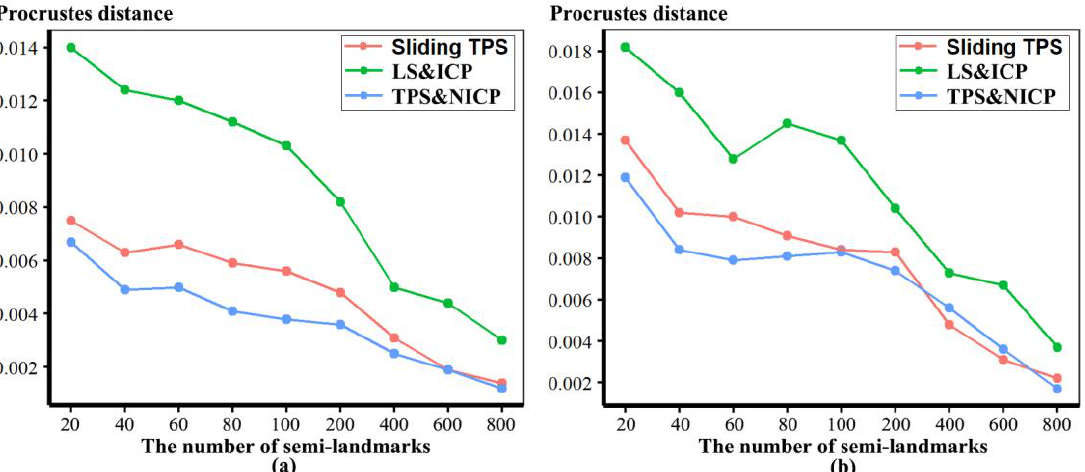
Figure 19. Procrustes distances, after re-semilandmarking and re-warping, between the allometrically scaled head surfaces derived from the maximum density and those from lower semilandmark densities. ( a ) Procrustes distances between predicted surfaces at the maximum centroid size. ( b ) Procrustes distances between predicted surfaces at the minimum centroid size.